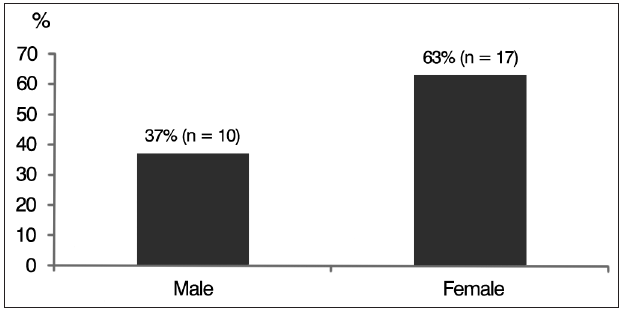
Graph 2. Gender percent distribution of subjects with auditory neuro- pathy spectrum disorder (ANSD).